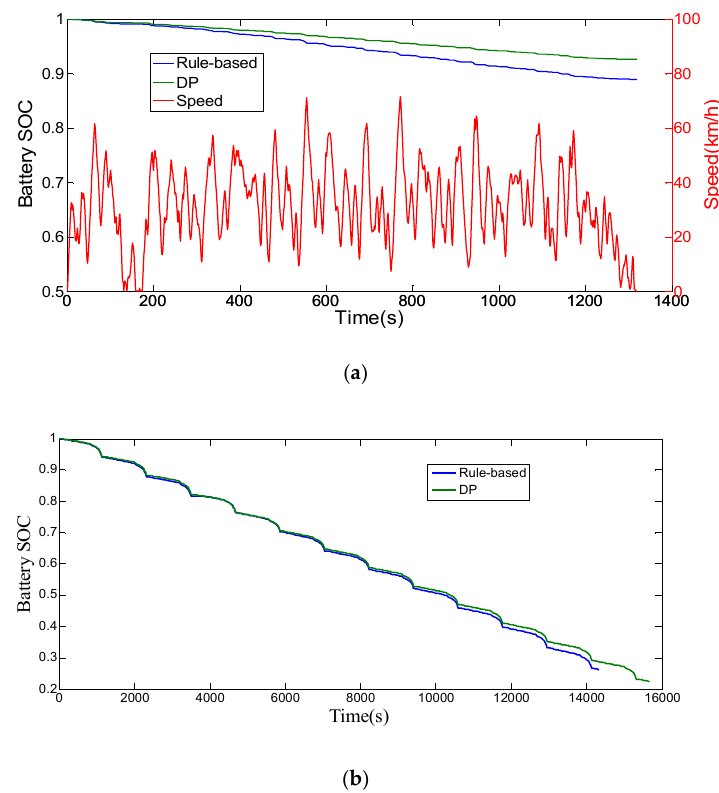
Figure 18. SOC change of battery under actual road driving cycle. 395